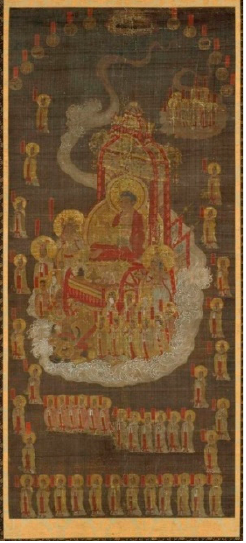
Figure 4. Chishengguang jiuyaotu 熾 盛 光 九 曜 圖 (Tejaprabh¯a Buddha Subduing the Nine Luminaries), Historical Relics Preservation Institute of Yingxian Wooden Pagoda 应 县 木 塔 文 保 所 , Hand-colored woodblock print, 50 cm × 94.6 cm, Liao period, ca. 1000.